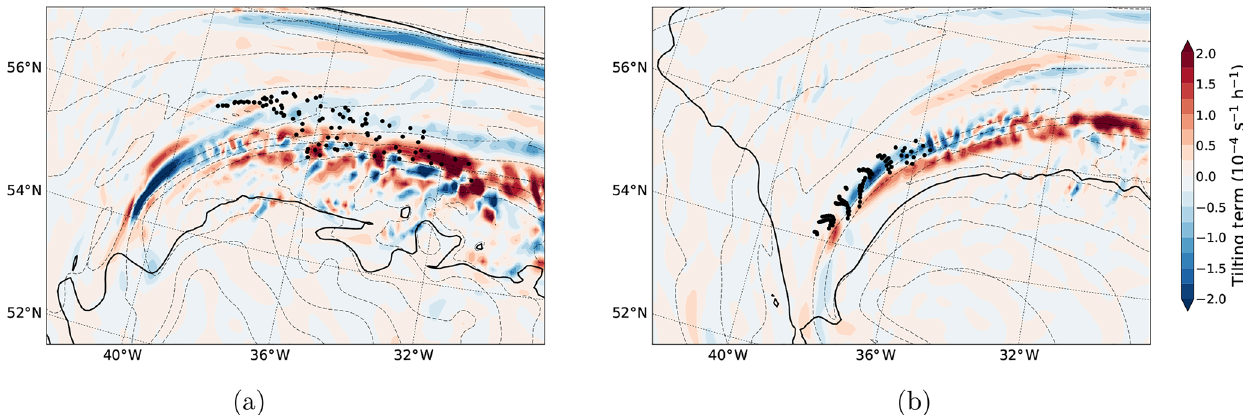
Figure 9. Tilting term of the vertical component of the vorticity equation (shading), θ w (thin dashed contours every 1K) and cloudy regions (RH ice = 80%; black solid contours) at (a) 745hPa at 81h from run start and (b) 685hPa at 86h. Black dots show the locations of the trajectories. The domain plotted is indicated in Fig.